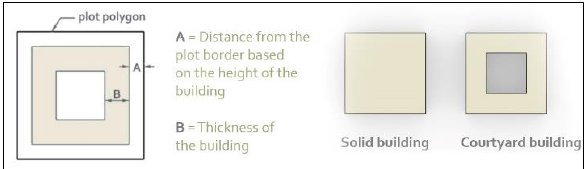
Figure 6. [Left] Example of design parameters for courtyard buildings. [Right] Available typologies for (new) buildings.